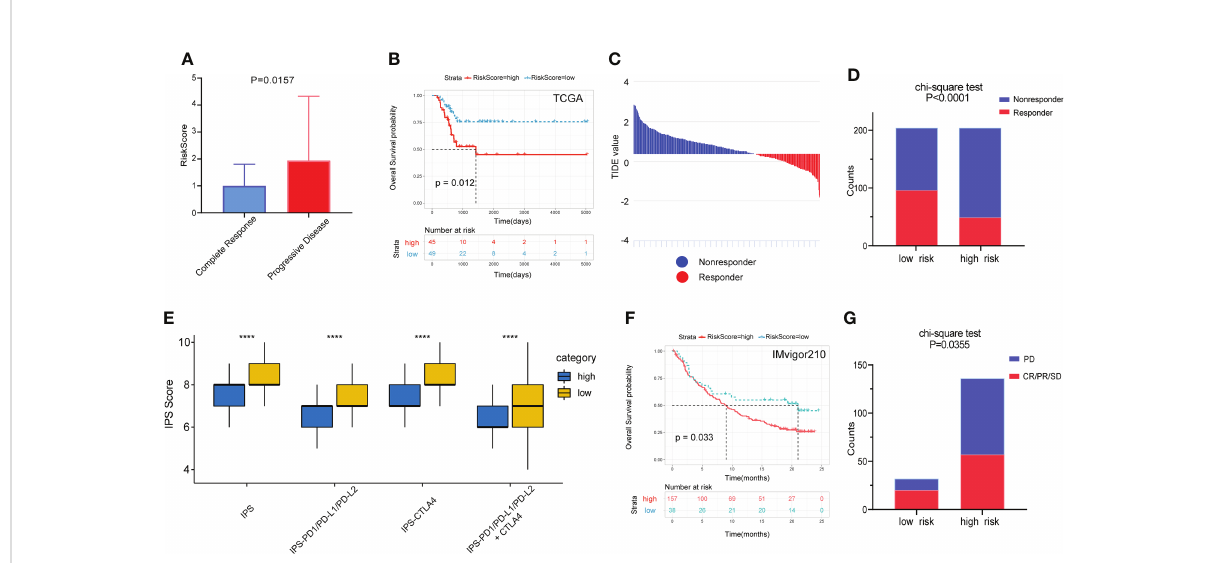
FIGURE 7 Prognostic value of the gene signature to chemotherapy and immunotherapy. (A) Comparison of RS among patients with complete response and progressive disease after chemotherapy. (B) The KM survival curve of OS between high and low RS groups in patients after chemotherapy. (C) Distribution of TIDE value in TCGA cohort. (D) Comparison of the proportion of responders and non-responders in different RS groups of TCGA cohort. (E) The association between IPS and RS groups. (F) The KM survival curve of OS between high and low RS groups in the IMvigor210 cohort. (G) Comparison of outcomes after receiving immunotherapy in different RS groups in the IMgivor210 cohort.